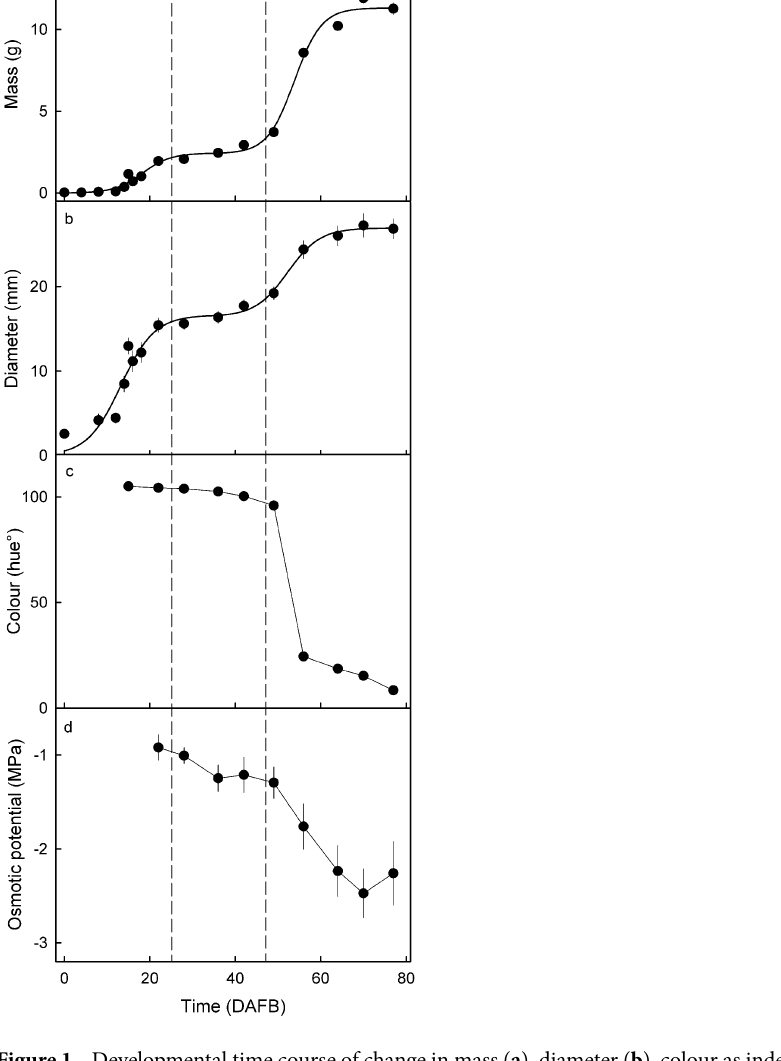
Figure 1. Developmental time course of change in mass ( a ), diameter ( b ), colour as indexed by the hue angle ( c ), and the osmotic potential of the expressed juice ( d ). The x -axis scale in days after full bloom (DAFB). Vertical dashed lines indicate stage I/II and stage II/III